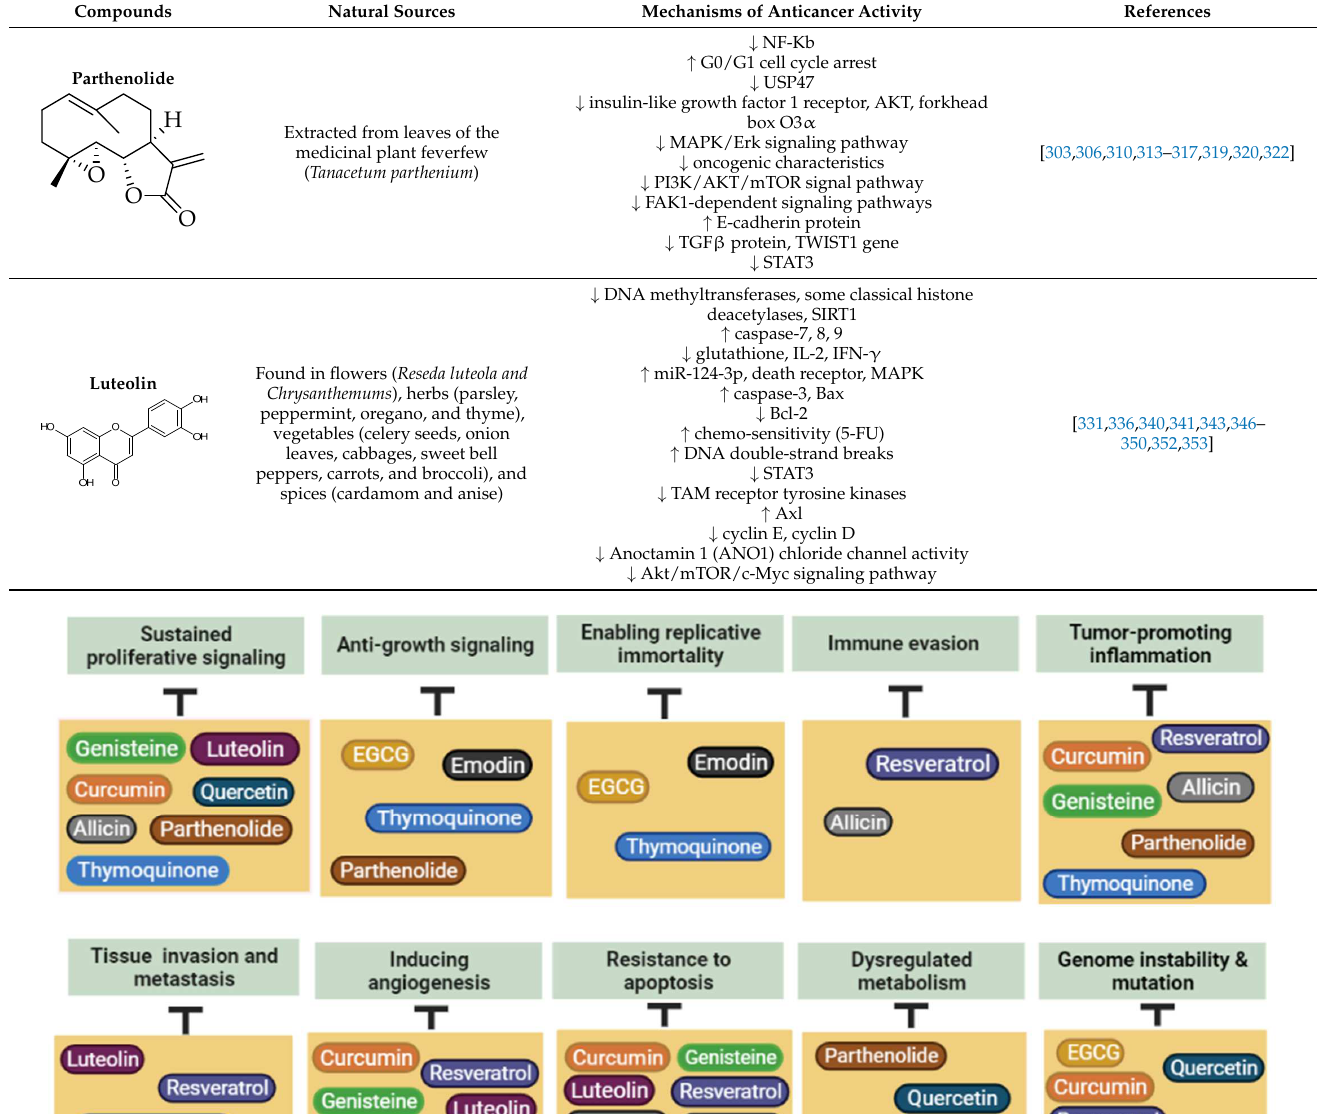
Figure 2. The effects of natural products on cancer hallmarks.